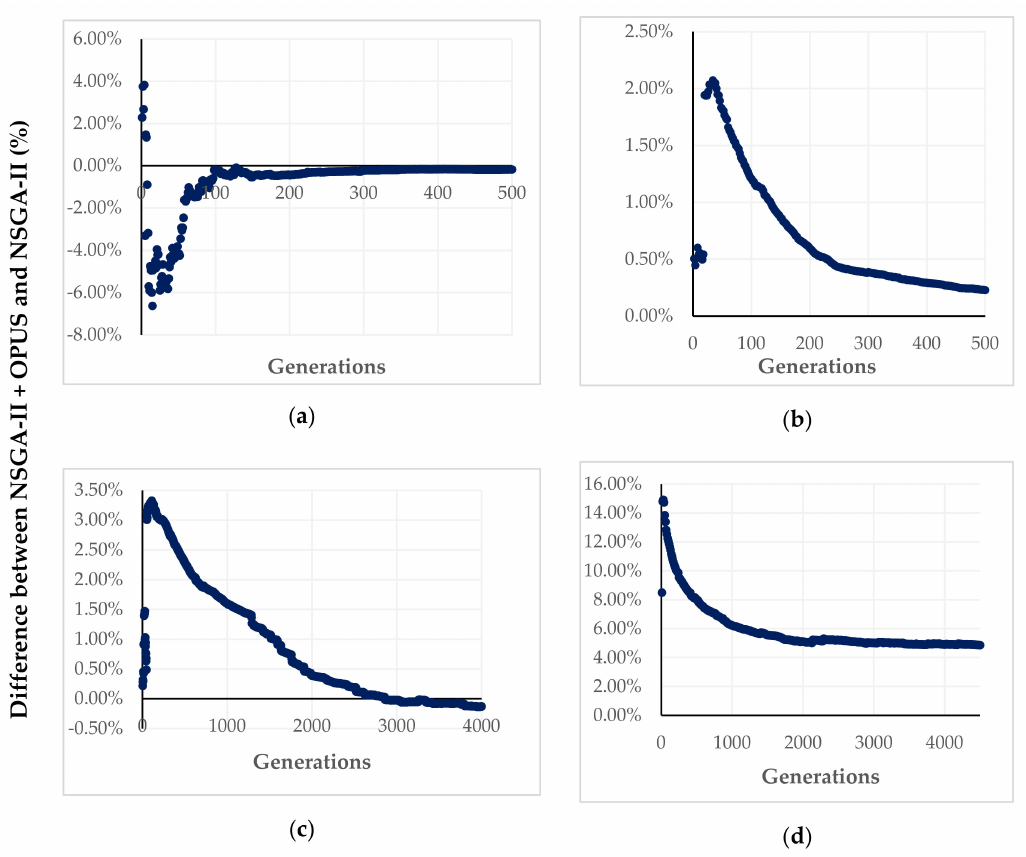
Figure 8. Percentage di ff erence for the HV between the results for NSGA-II and the proposed algorithm. ( a ) Hanoi; ( b ) Fossolo; ( c ) Modena and ( d )